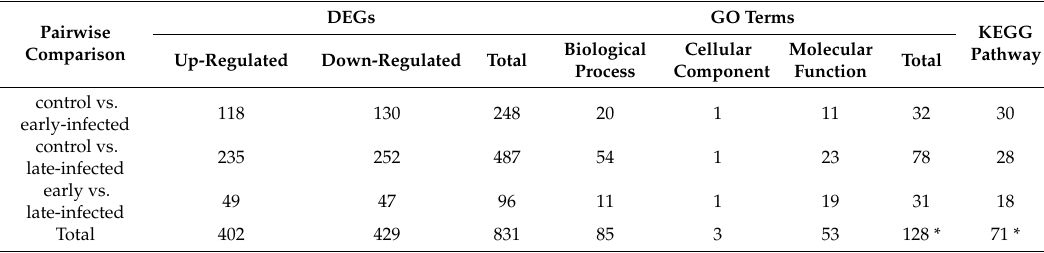
Table 1. Number of di ff erentially expressed genes (DEGs), Gene Ontology (GO) terms and Kyoto Encyclopedia of Genes and Genomes (KEGG) pathways ( p -value < 0.05) from the pairwise